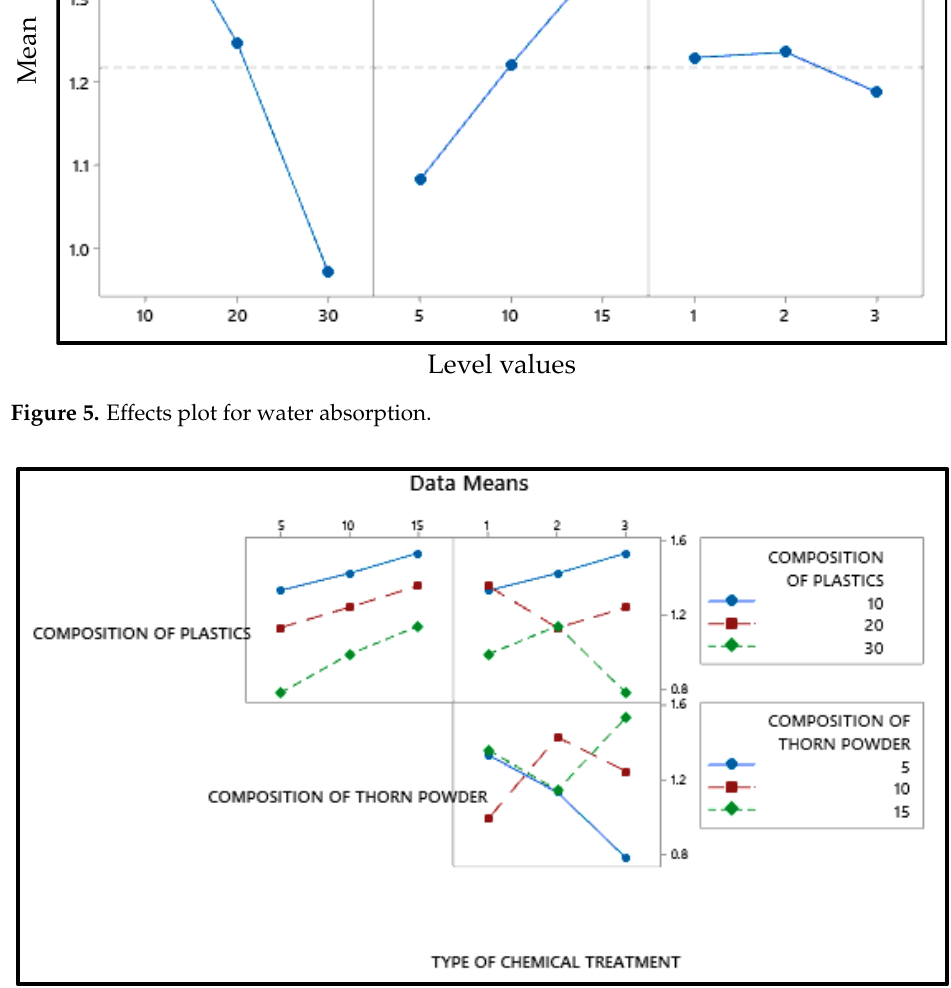
Figure 6. Interaction plot for water absorption.